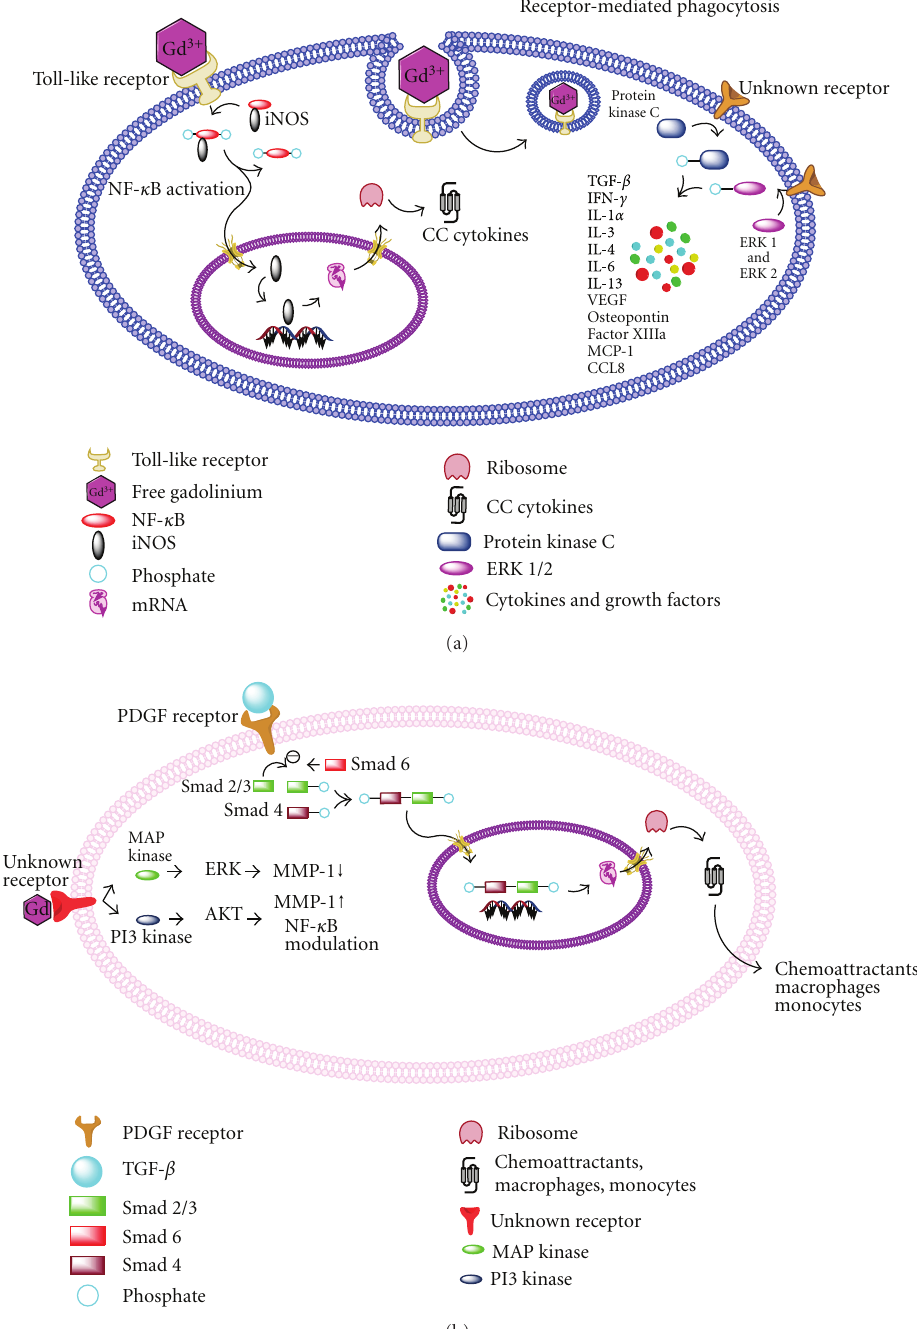
Figure 2: Schematic representation of activation of a macrophage and a